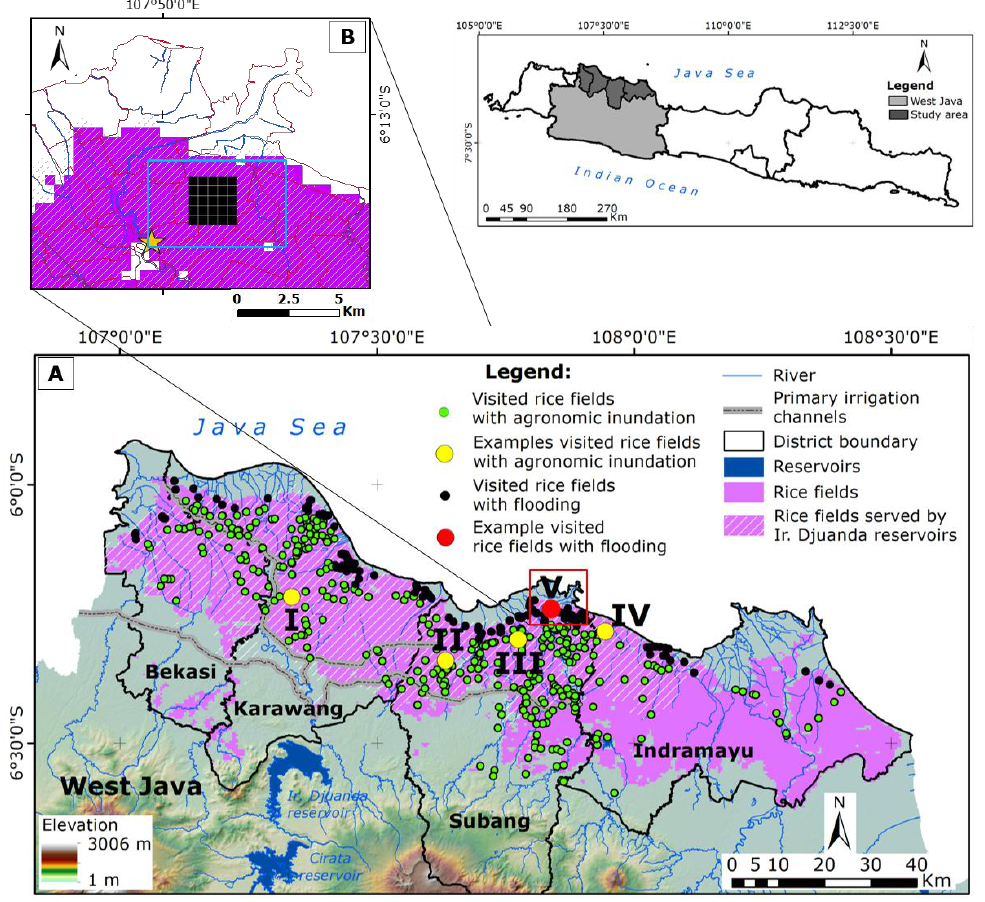
Figure 1. ( A ) Study areas: Irrigated rice fields (purple) in Bekasi, Karawang, Subang, and Indramayu districts (black line). Green and black dots represent visited rice fields with agronomic inundation and flooding, respectively. Yellow dots (I–IV) and a red dot (V) represent examples of rice fields with agronomic inundation and flooding, respectively. Yellow dots and the red dot in Figure 1A correspond to Figure 5. ( B ) Blue rectangle represents swampland rice fields affected by the dike failure on January 18, 2014. Yellow star marks the location of the dike failure (inset). Conditions in the black rectangle in Figure 1B are explained in Table 1.